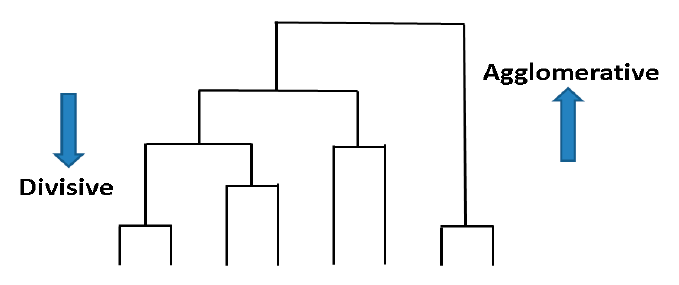
Figure 2. Hierarchical Clustering.